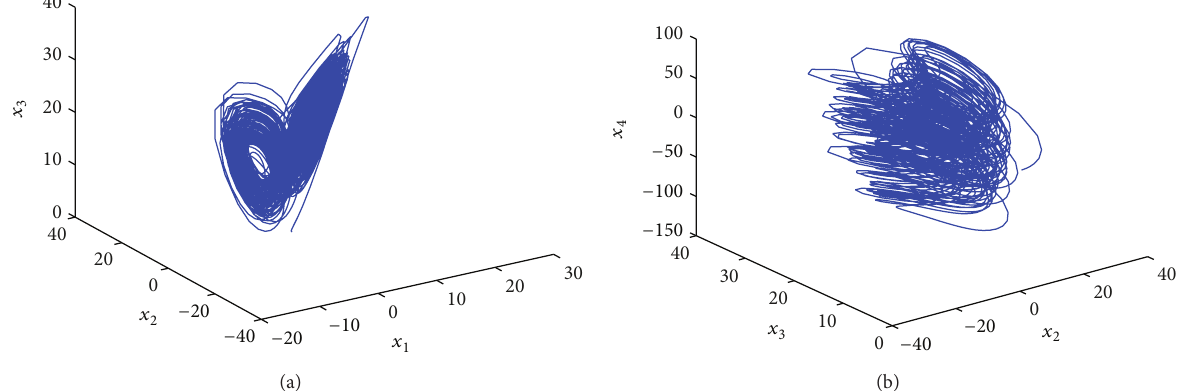
Figure 1: Hyperchaotic attractors in the fractional-order hyperchaotic Chen system with 𝛼 = 0.96 . The panels (a) and (b) show the 3D views of 𝑥 3 − 𝑥 2 − 𝑥 1 and 𝑥 4 − 𝑥 3 − 𝑥 2 ,